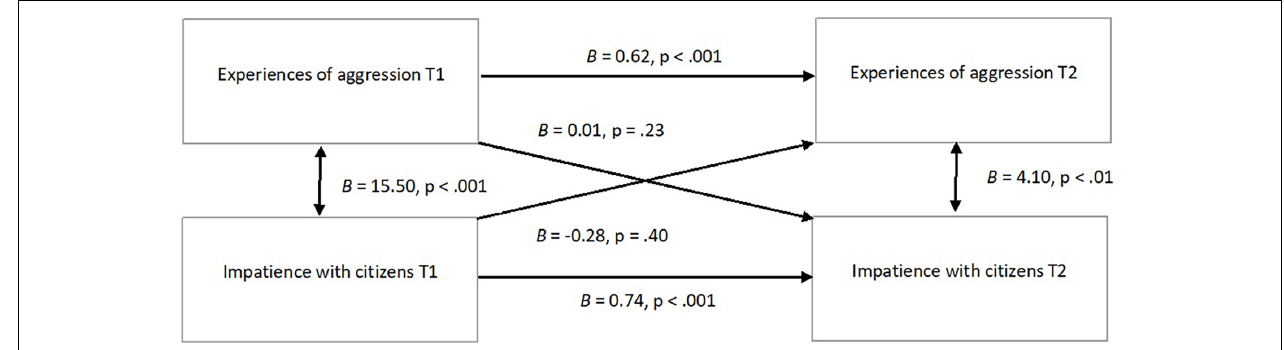
FIGURE 2 | Cross lagged panel model of experiences of aggression and impatience with citizens, using FIML ( N =